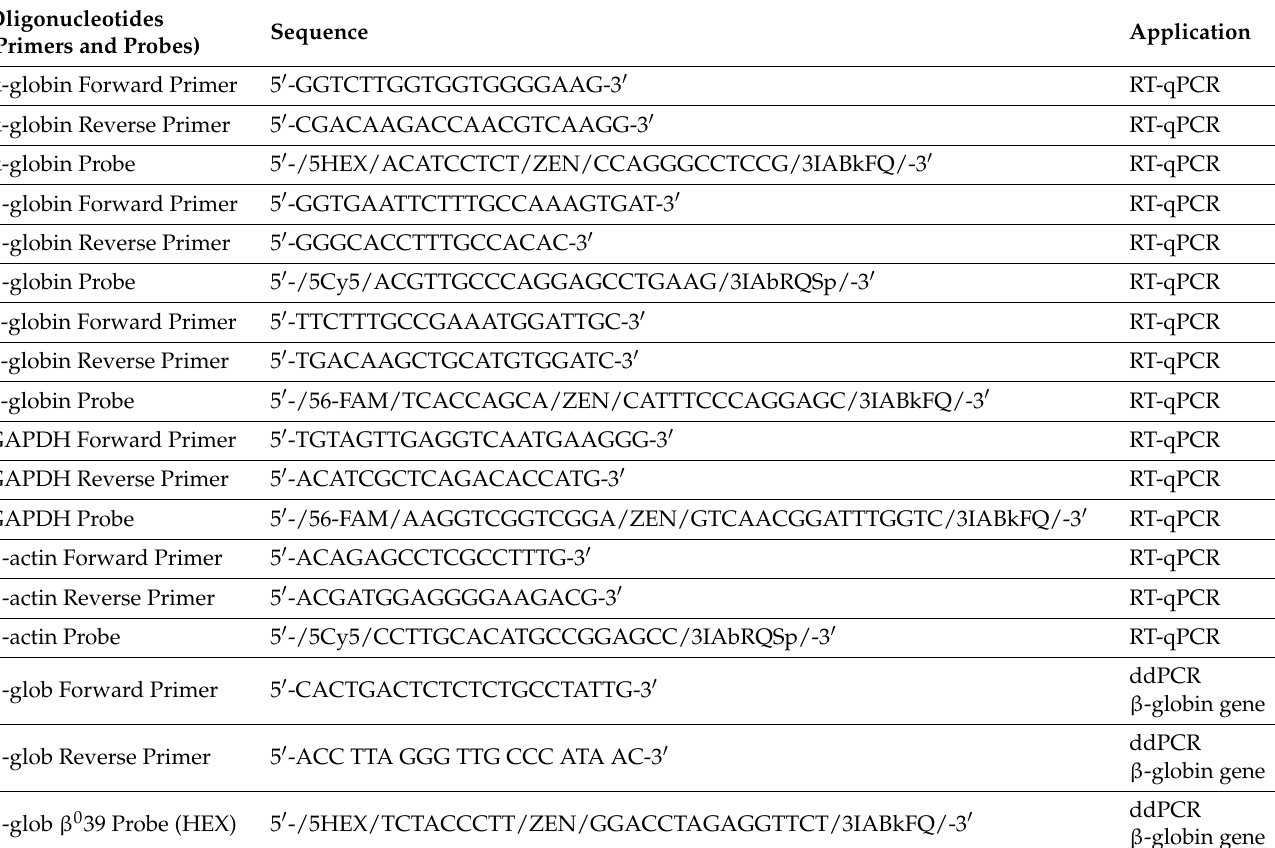
Table 1. List of oligonucleotides (primers and probes) used to evaluate the correction degree obtained on the β -globin gene and study the accumulation of α -, β - and γ -globin